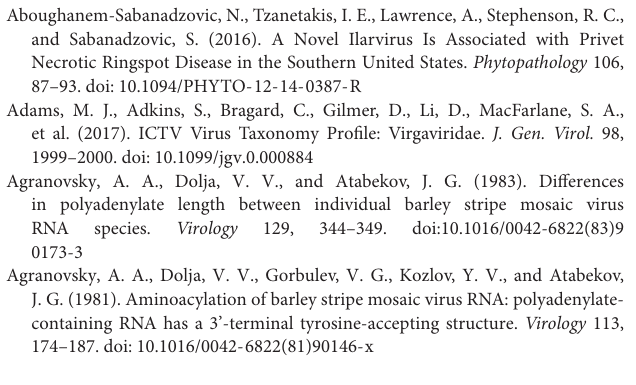
sRNA libraries HYT-23 and HYT-24 were mapped to the LigMV gRNA α , β , and γ reference sequences and counted by size (20, 21, 22, 23, 24, 25 nt, total 20–25 nt), polarity (forward, reverse, total) and 5 (cid:48) -nucleotide identity (5 (cid:48) A, 5 (cid:48) C, 5 (cid:48) G, 5 (cid:48) U). The counts are presented in three tables: two with counts of reads mapped to the viral reference sequences with zero (A) or up to 2 (B) mismatches, and one table with 5 (cid:48) -nucleotide frequencies of viral sRNAs mapped to the viral references with zero mismatches (C)